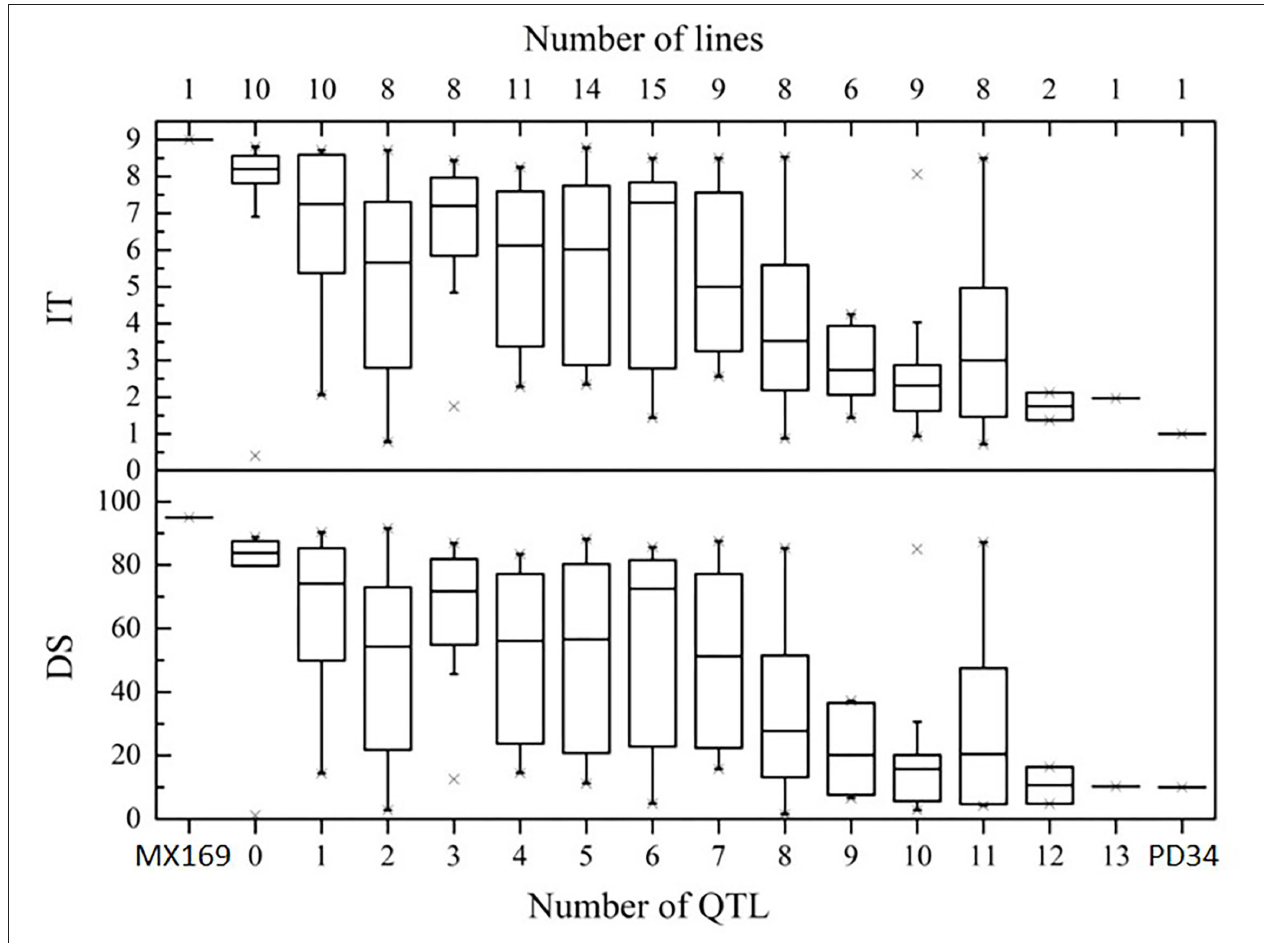
FIGURE 5 | Effects of individual QTLs and their combinations on stripe rust scores illustrated by the mean infection type (IT) and disease severity (DS) scores of the RILs from the cross of Mingxian 169 × Pindong 34 in combined environments (MY and YL). The box plots indicate the infection type (IT) and disease severity (DS) associated with the identified QTL and their combination. The resistance alleles present in the group are indicated by the name of the chromosome where the QTL is located. The number of RILs grouped in each class is indicated in parentheses by each class name. Error bars represent ± 1